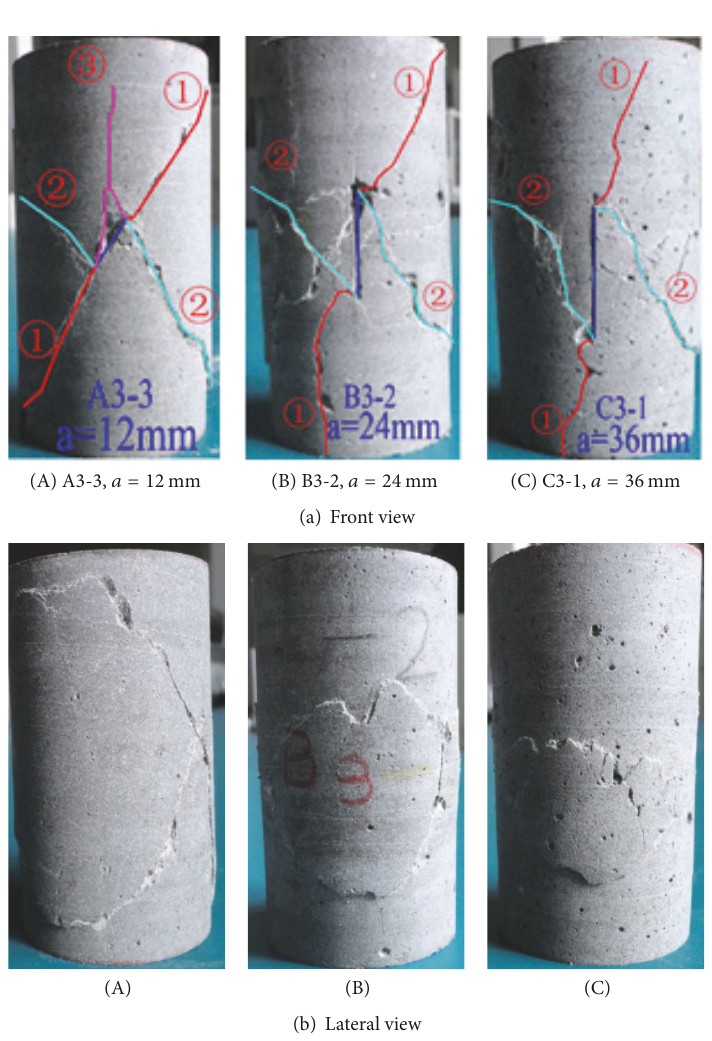
Figure 7: Fracture modes of specimens with different joint